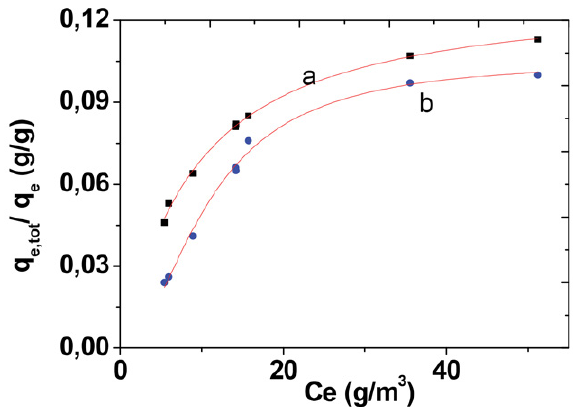
Figure 6. Adsorption Isotherms a-co-adsorption of toluene -H 2 O; b-toluene on Adsorbent 4 (rH = 70%, t = 22